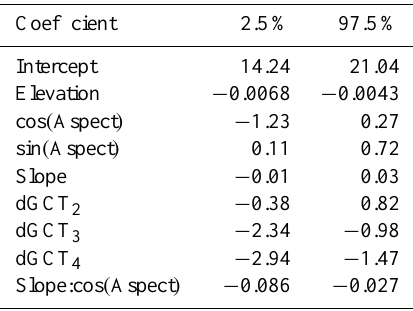
coefficients (Model (3)).